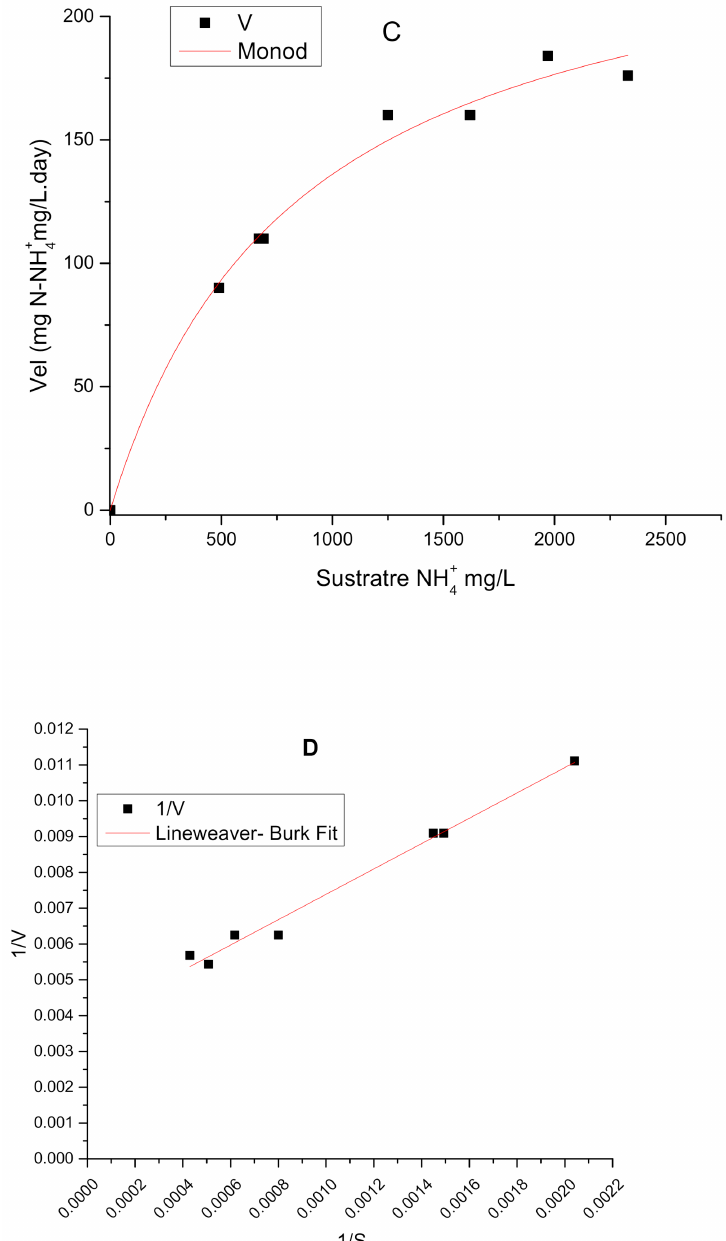
Figure 1. ( A ) Effect of initial ammonium concentration during lag phase. ( B ) Velocity evolution over time as a function of substrate addition. ( C ) Maximum velocity as a function of initial substrate and time ( D )